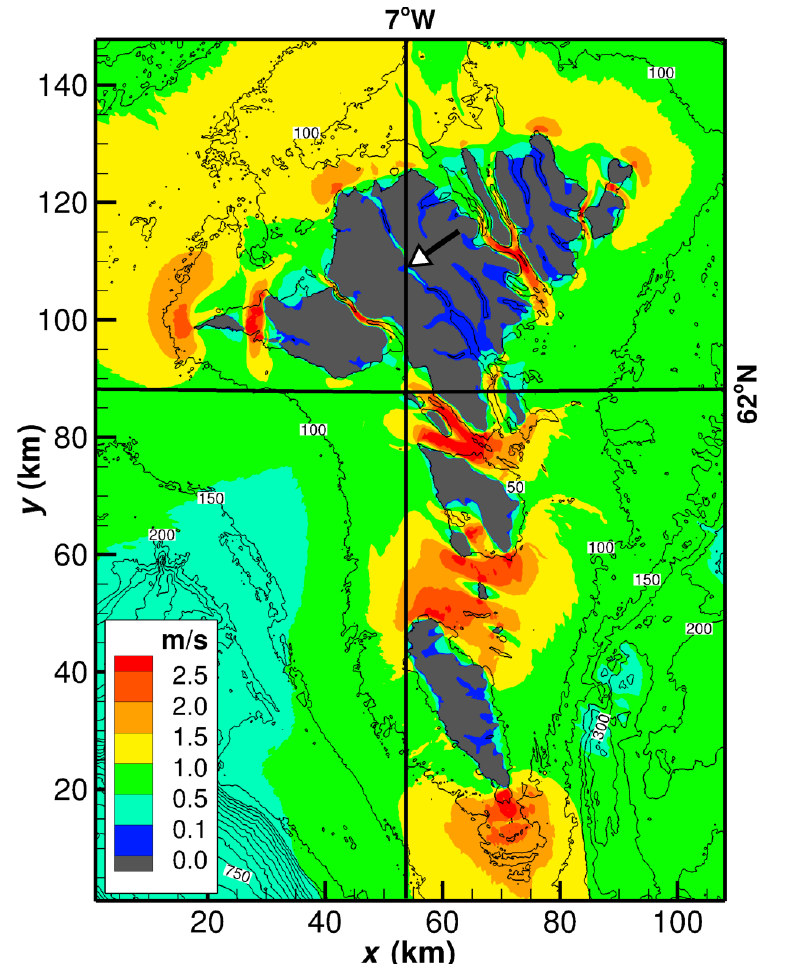
Fig. 1. Maximum tidal current velocity around the Faroe Islands provided as the sum of the semi-major axes of the 6 dominating constituents (Simonsen & Niclasen 2011). Thin contour lines provide the water depth (m). The white arrow indicates the location of the large narrow